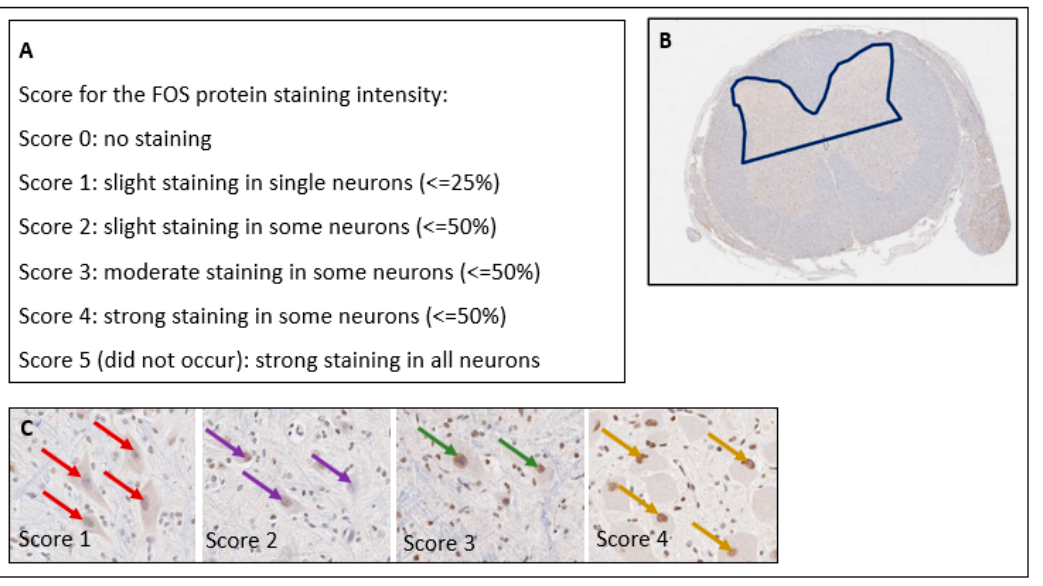
Figure 1. Semiquantitative Evaluation of the FOS Staining Intensity. ( A ) Score for the FOS staining intensity and frequency. ( B ) Area evaluated in the spinal cord. ( C ) Examples of different scores.